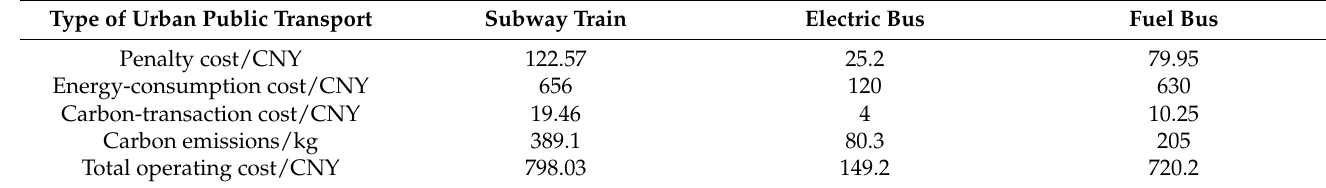
Table 1. Results of urban public transport operation cost under carbon-trading